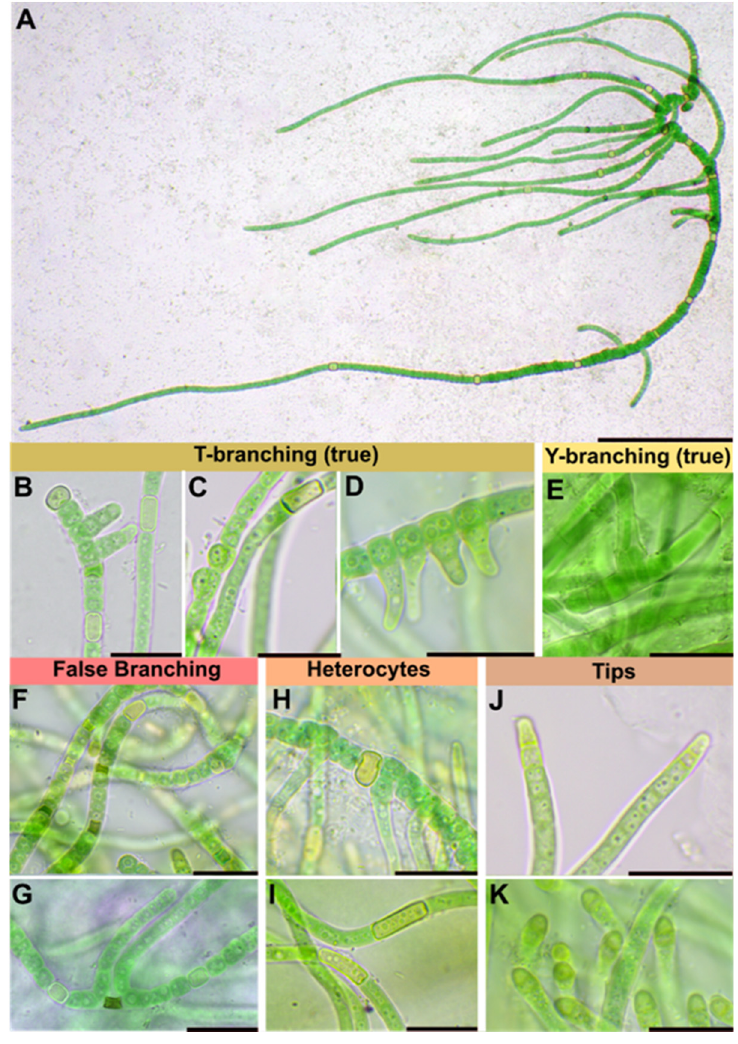
Figure 2. Morphological details of Symphyonema bifilamentata sp. nov. ( A ) Overview image showing a mature filament growing on agar with swollen basal section that is tapered at heterocytes and several bilateral branches with heterocytes. Scale bar 50 µm. ( B – D ) Formation of true T-branching out of young basal sections. € True Y-branching with two elongated cells that unite to a lateral section. ( F – G ) Necridic cells in young basal sections in ( F ) and scytonematoid false branching in ( G ) where both cells surround a necridic cell form lateral filaments that grow out of the sheath. ( H ) Squeezed globose heterocyte of basal section. ( I ) Elongated heterocytes of lateral branches. ( J ) Yellowish apical cells of young lateral branches and ( K ) indicating yellowish rounded tips of mature lateral branches. Note fine granulation of lateral sections in ( I – K ) compared to the coarse vacuole-like granulation of basal sections in ( B – D ) and ( H ). Scale bar of ( B – K ) indicates 10 µm.